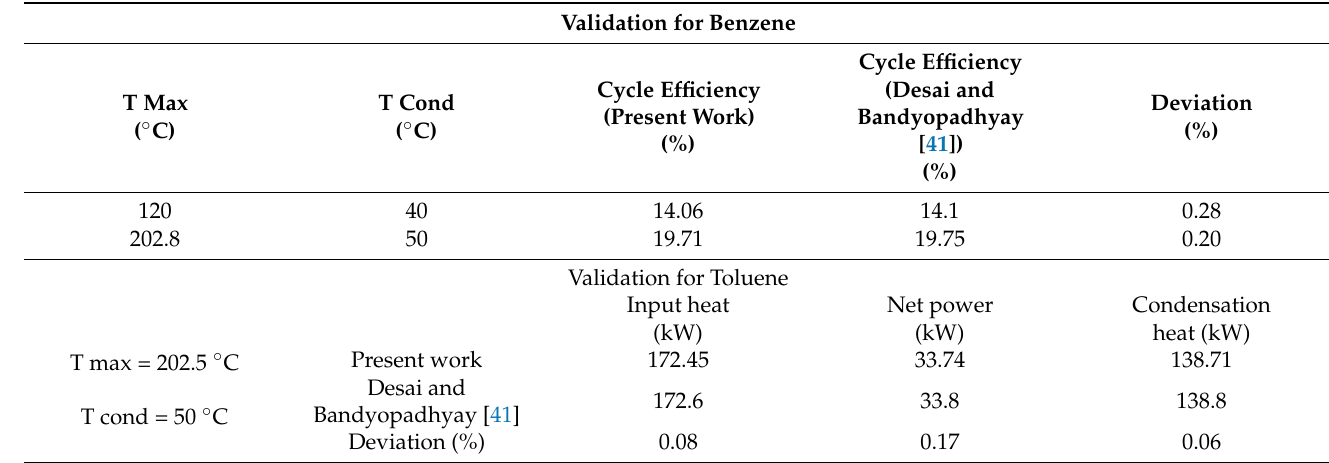
Table 7. Validation of the ORC model using data from Desai and Bandyopadhyay [41]. Validation for Benzene